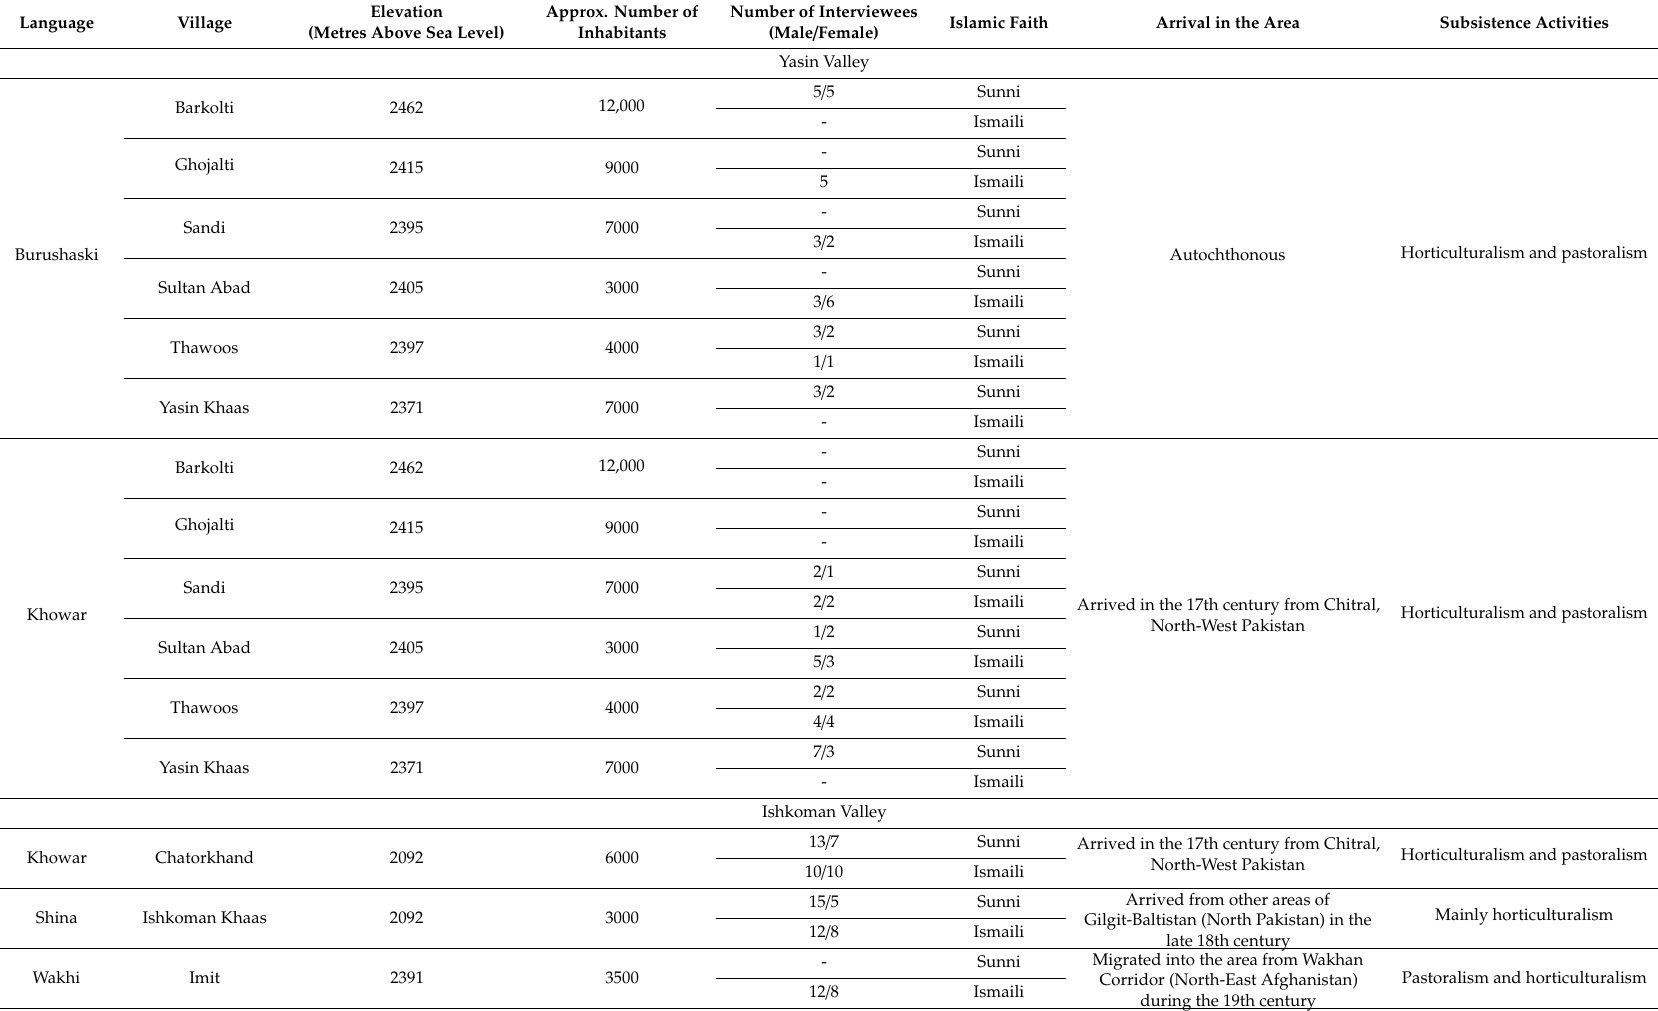
Table 1. Characteristics of the visited mountain villages and studied